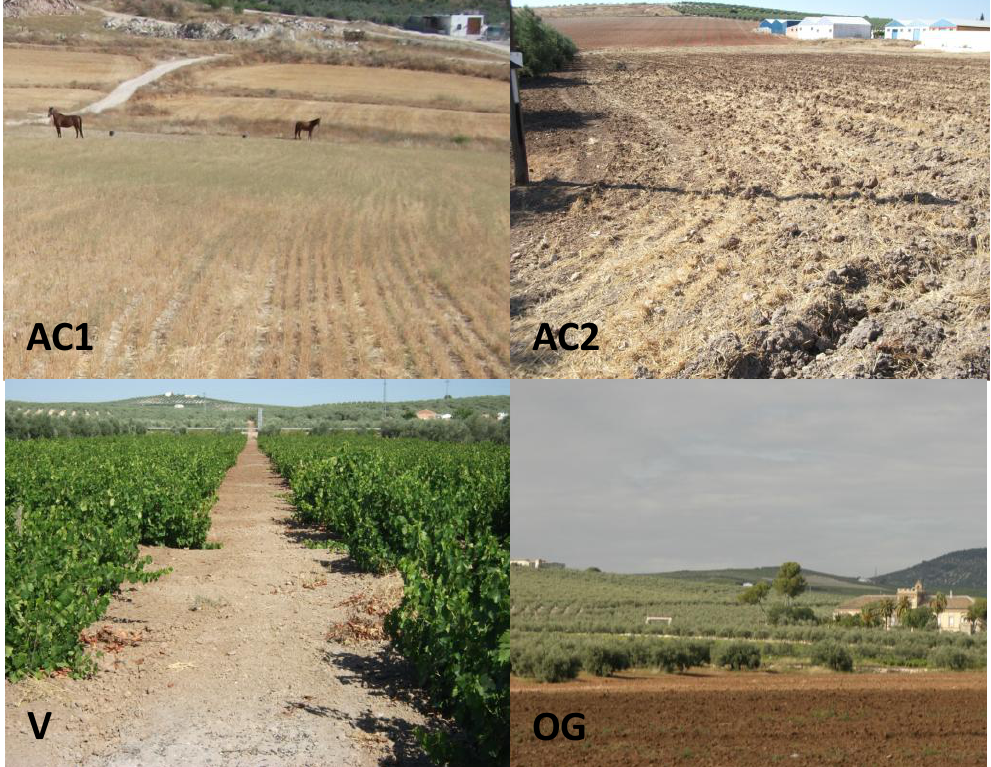
Fig. 3. Montilla-Moriles D.O. (AC1) Arable crop, systems using animal power (plow with mules) with lightweight reversible plows. (AC2) Arable crop, heavy machinery – news mechanized equipment, (V) Vineyard modern, (OG) Olive groves.